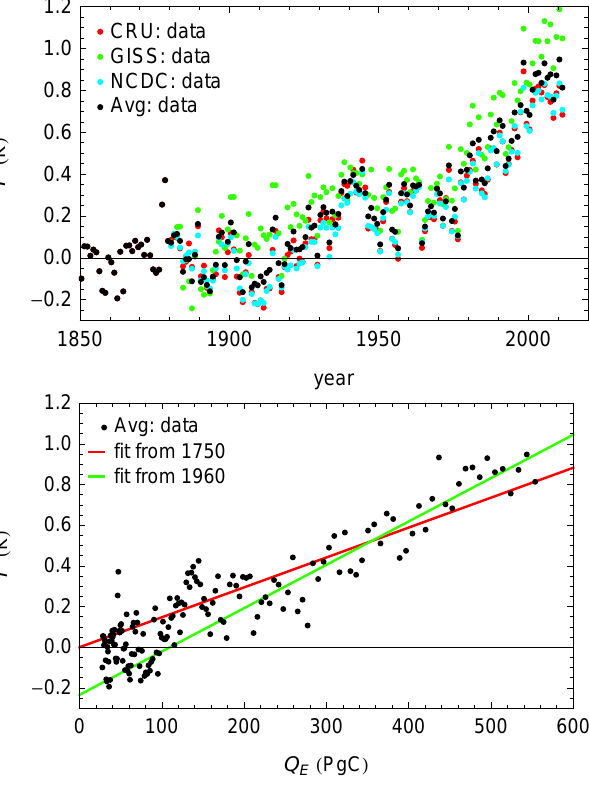
Fig. 5. Perturbation global temperature T (referenced to 1880– 1900) from three data sources, as a function of time t (upper panel) and of cumulative CO 2 emissions Q E (lower panel). The average of all three series is shown as black points. In the lower panel, the red line is a linear fit to all available T data (average over 3 sources) constrained to pass through the origin; green line is a linear fit to data from 1960 to 2011, not constrained to pass through the origin. Slopes are α =1.47KEgC − 1 (red) and 2.13KEgC − 1 (green). Data sources: Appendix